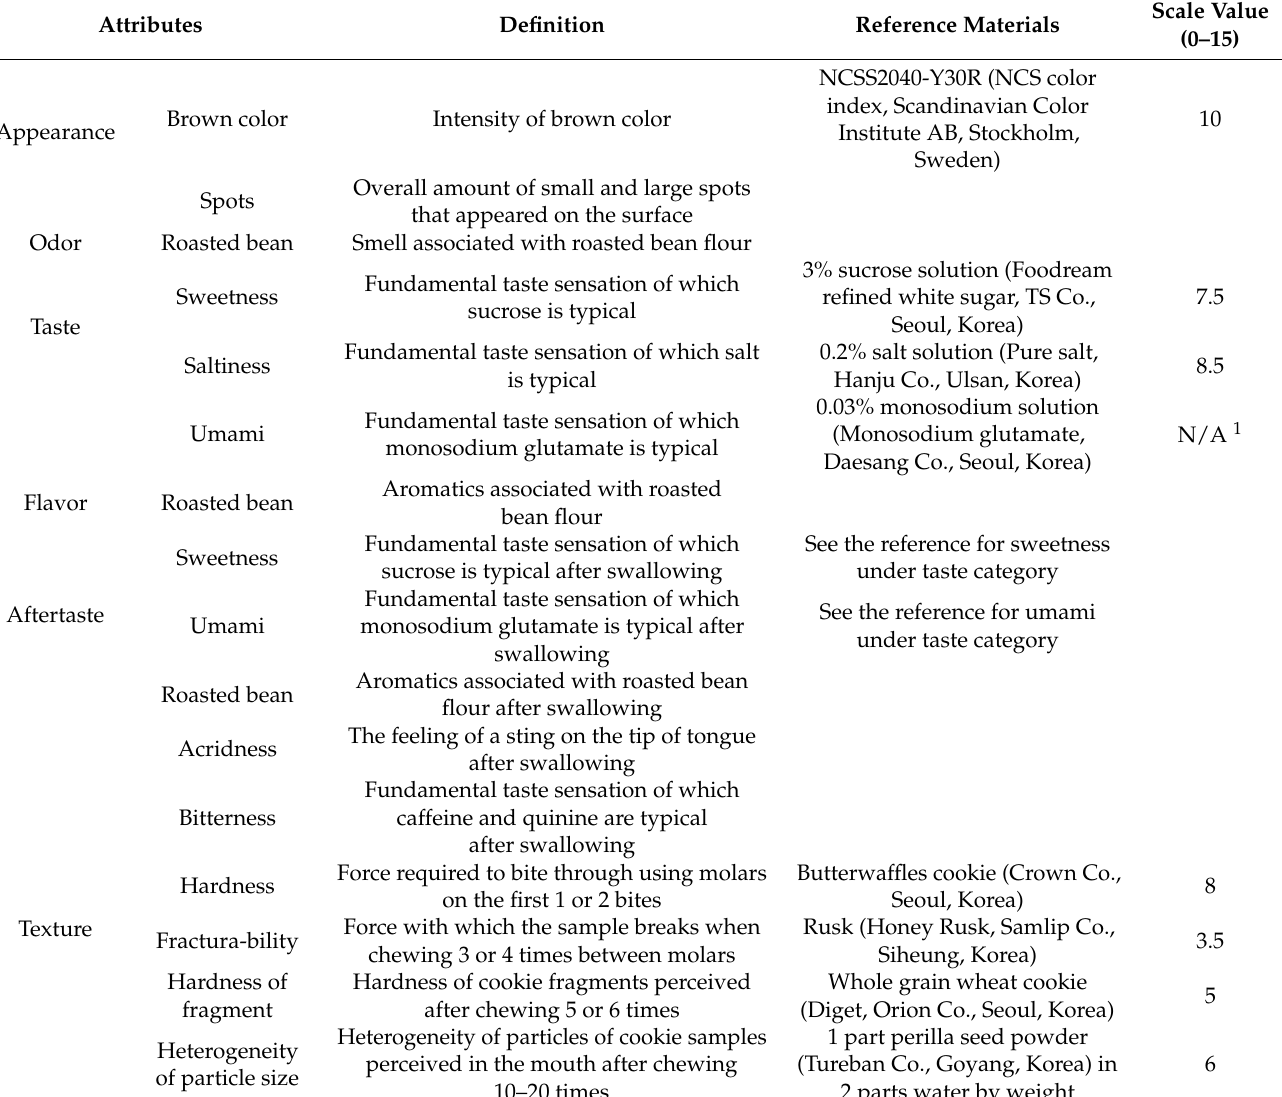
Table 3. Definitions and reference materials for descriptive attributes of sweetener cookie